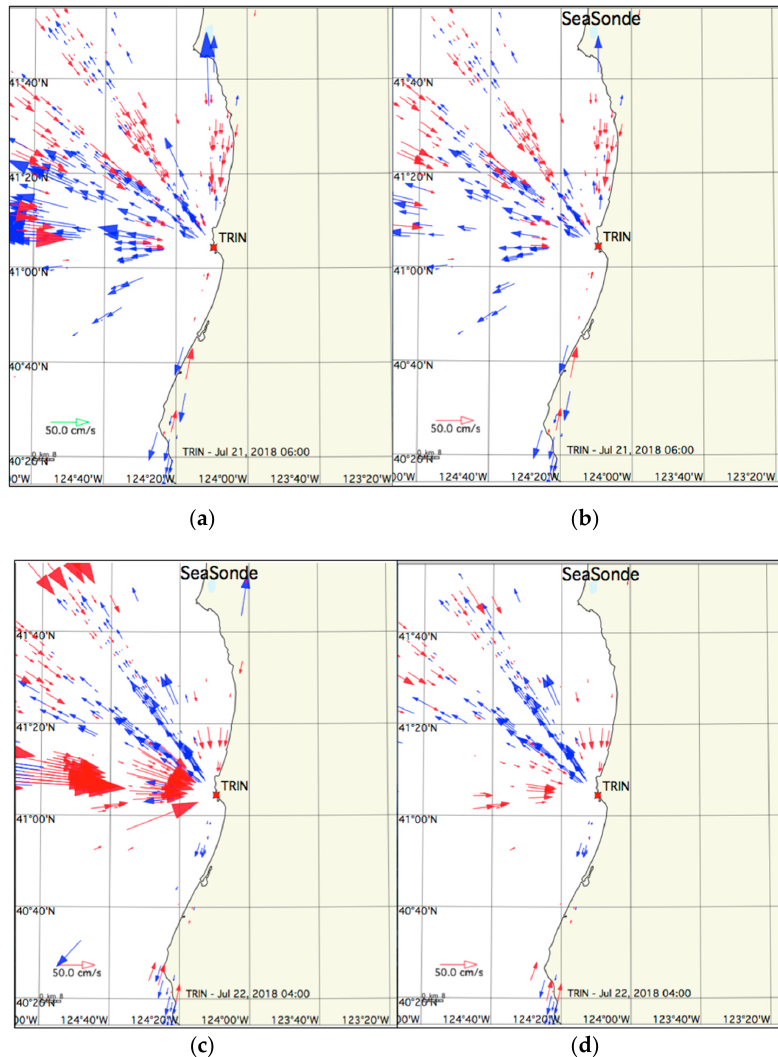
Figure 6. Comparison of current velocity maps obtained with and without QC (Quality Control) at Trinidad, California. Radar transmit frequency: 4.8 MHz. The threshold S lim was set to 25. 21 July, 2018, 6:00 a.m.: ( a ) without QC, RMS av = 32.2 ( b ) with QC, RMS av = 11.2. 22 July, 2018, 4:00 a.m.: ( c ) without QC, RMS av = 83.9 ( d ) with QC, RMS av = 12.8.